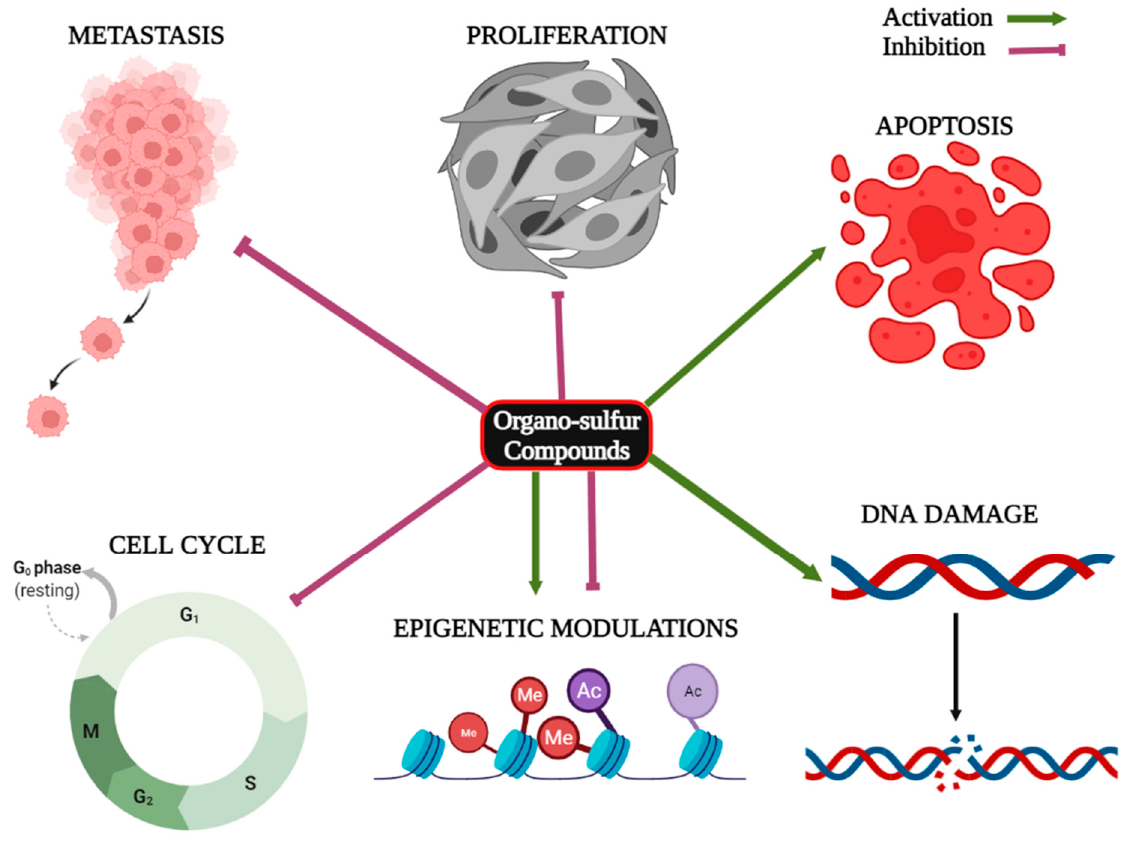
Figure 3. Role of organo-sulfur compounds in the inhibition of proliferation, metastasis and cell cycle progression, apoptosis induction, DNA damage, and epigenetic modulations in cancer.